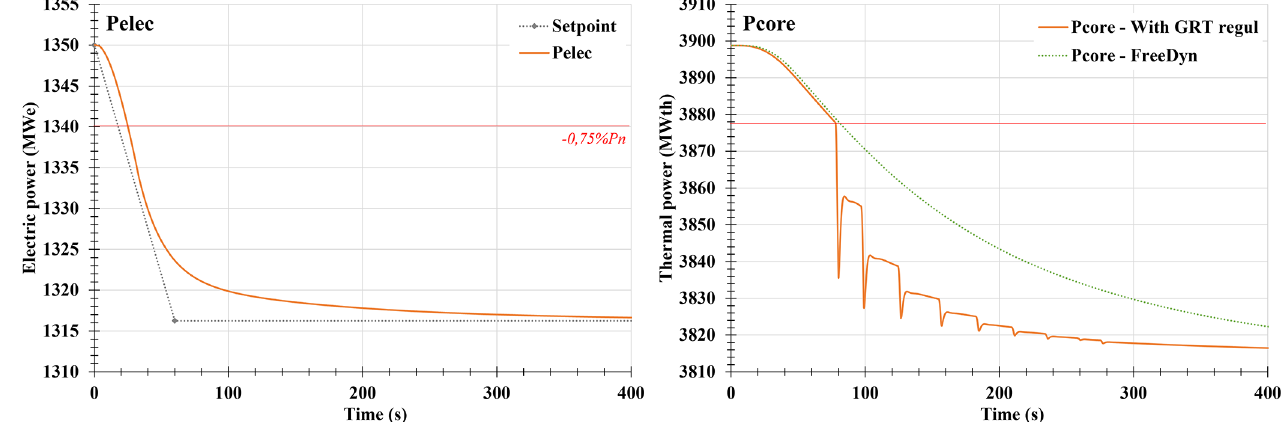
Fig. 1. Electrical and thermal powers during a primary frequency control